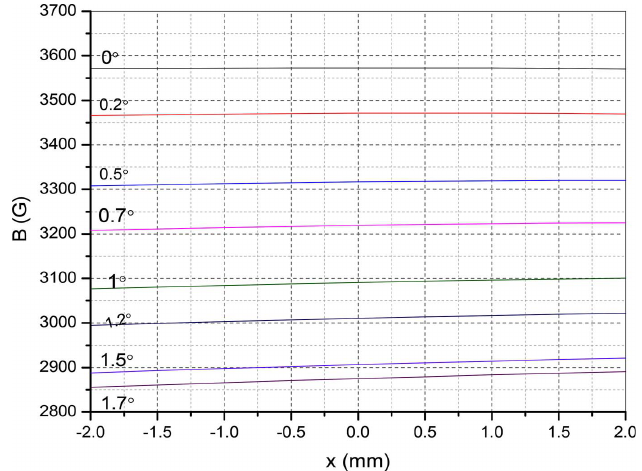
Figure 13 Effect of the angular tilt on the good field region.